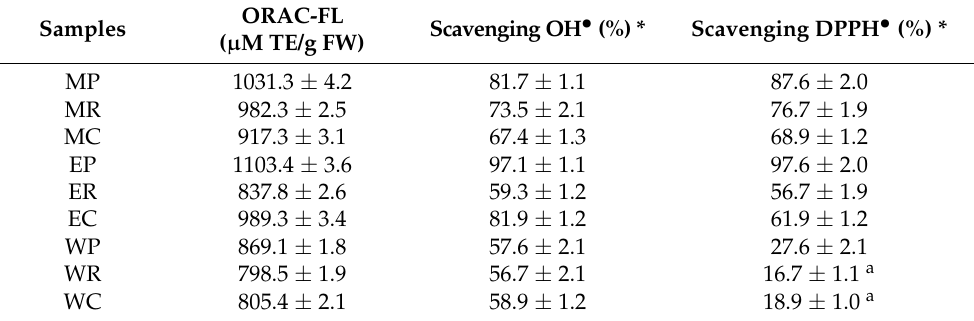
Table 1. Results from the antioxidant capacity of Argylia vitroplant and root extracts measured by fluorescence and ESR